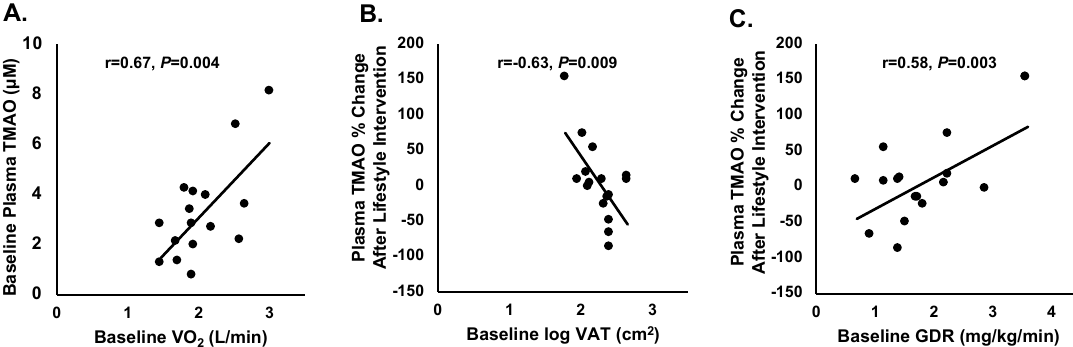
Figure 3. ( A ) Correlation between baseline plasma TMAO ( µ M) and baseline VO 2max (L / min) (r = 0.67, p = 0.004). ( B ) Correlation between baseline log transformed visceral adipose tissue (VAT) and percent change in TMAO after the lifestyle intervention (r = − 0.63, p = 0.009). ( C ) Correlation between baseline glucose disposal rate and percent change in TMAO after the lifestyle intervention (GDR (glucose disposal rate): r = 0.58, p = 0.003).